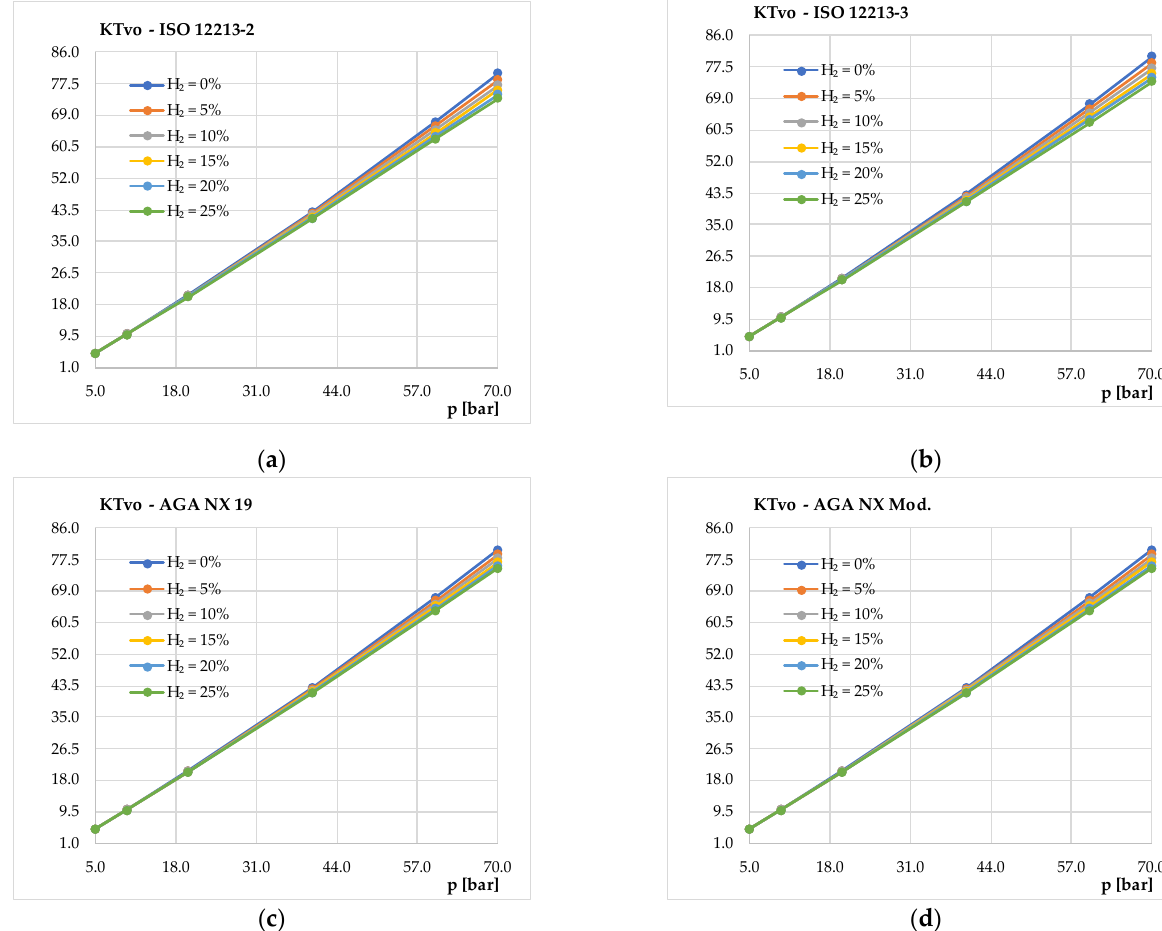
Figure 5. Trend of the volumetric correction factor in NG and H 2 mixtures: ( a ) ISO 12213-2, ( b ) ISO 12213-3, ( c ) AGA NX 19 and ( d ) AGA NX 19 Mod.